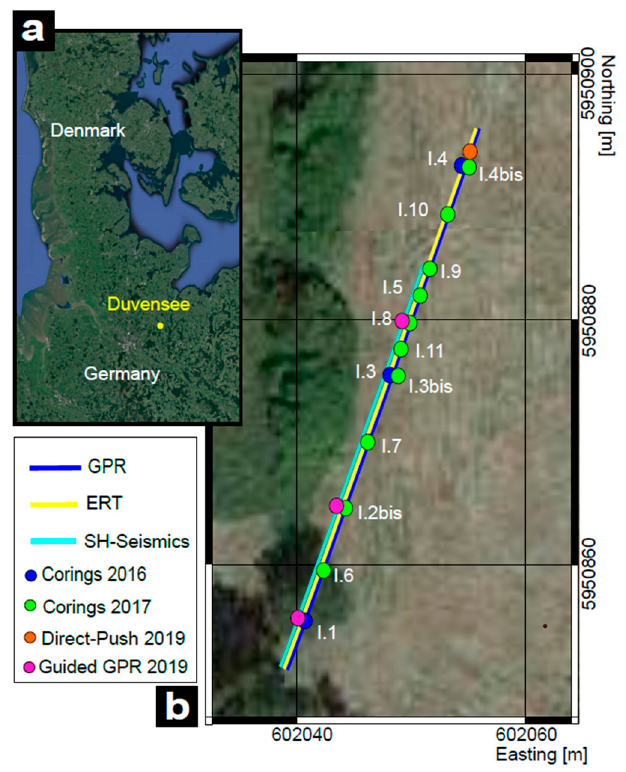
Figure 1. Area of investigation including geophysical and coring surveys; ( a ) the location of ancient Lake Duvensee; ( b ) geophysical measurements, corings and Direct-Push done in the area of interest (color coded dots).